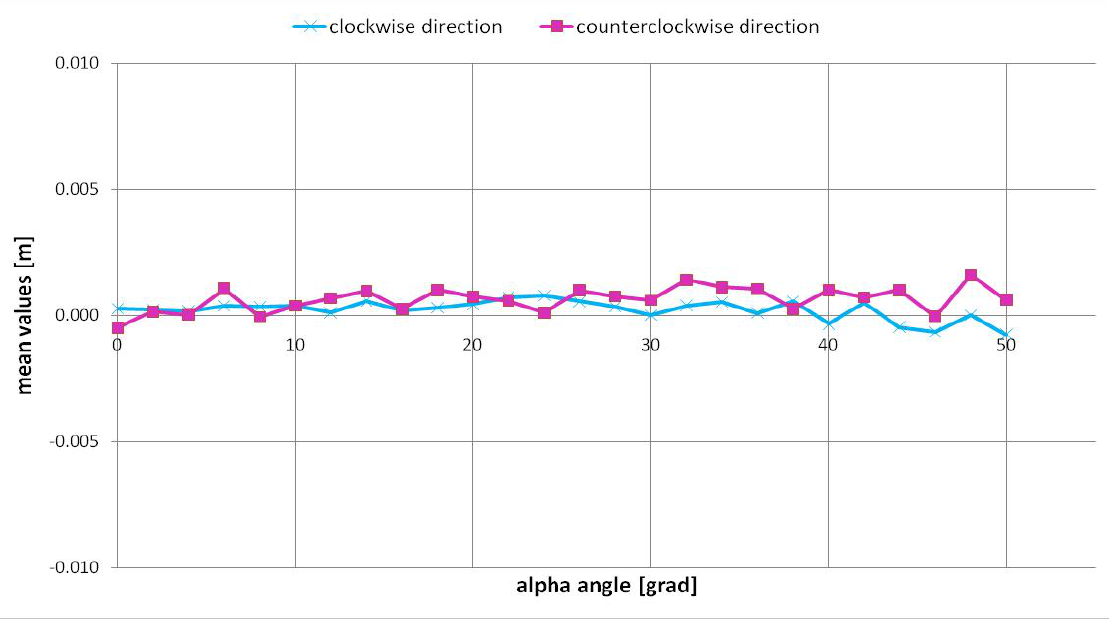
Figure 10. Mean values of the differences between range image and estimated reference